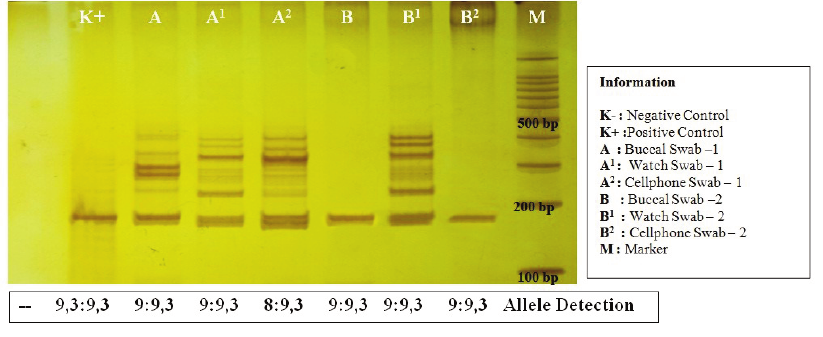
Figure 1. Visualization of STR CODIS PCR product using at locus THO1 (156–195